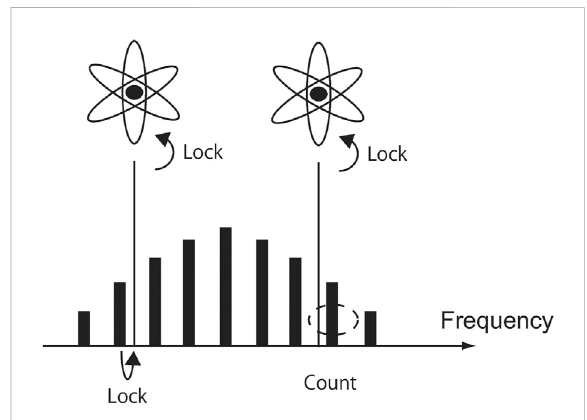
Concept for optical clock comparison via frequency combs. The frequency comb is locked to a fi rst optical clock, and compared with another optical clock via the use of frequency counters to measure the stability of the beat